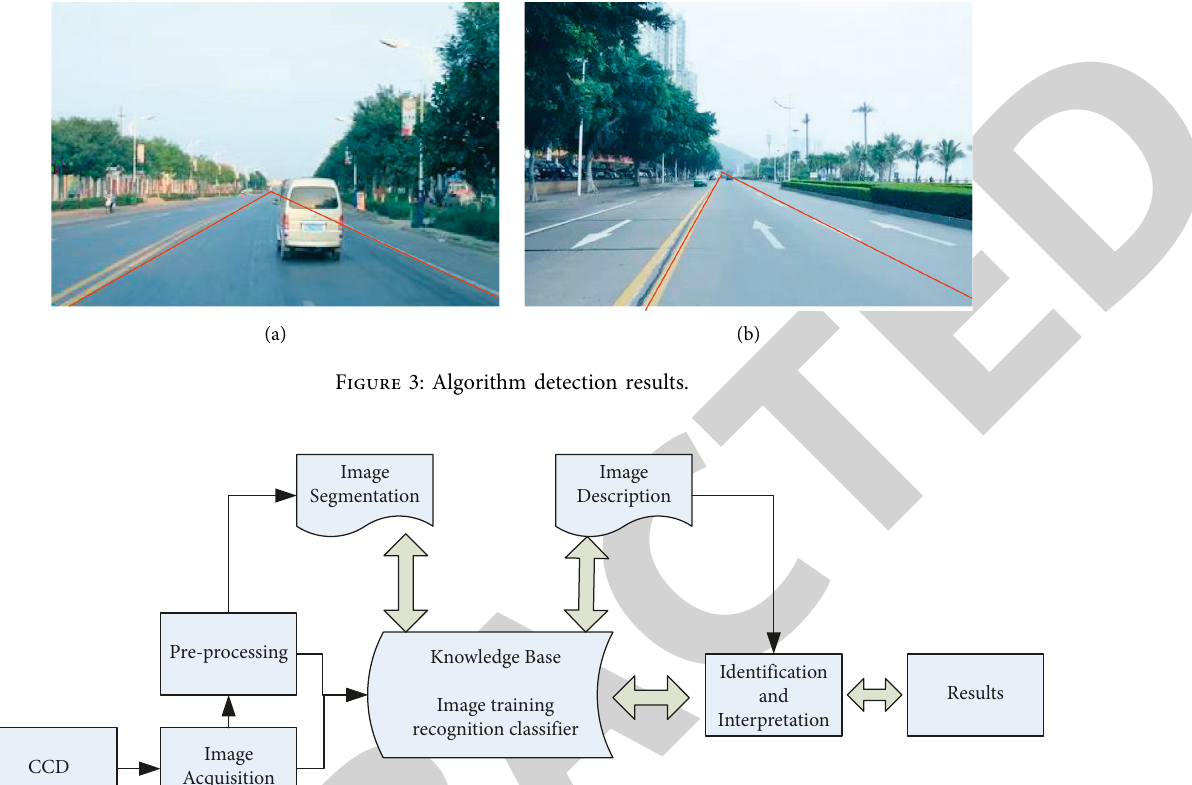
Figure 4: Image pattern recognition system composition.